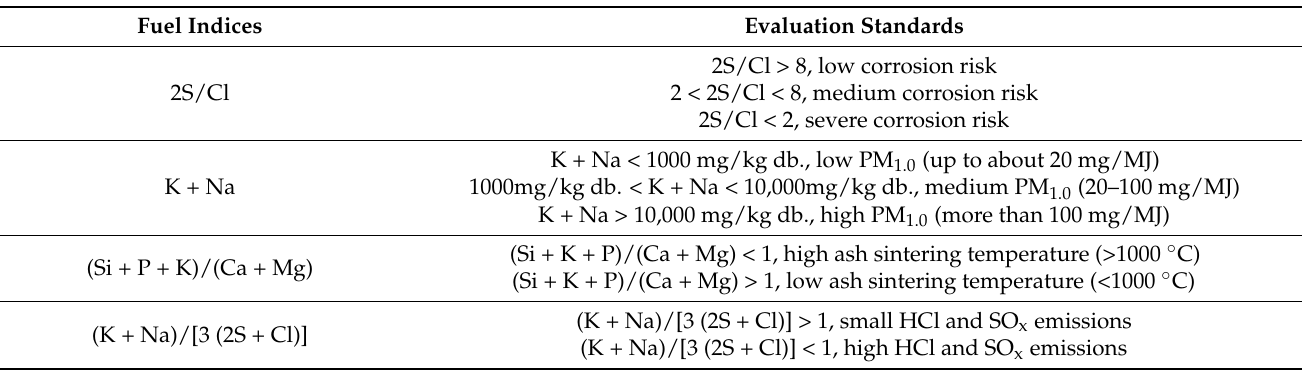
Table 4. Summary of evaluation standards for selected fuel indices